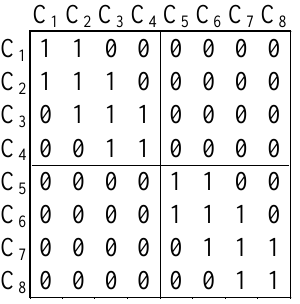
Figure 7. Separability matrix.